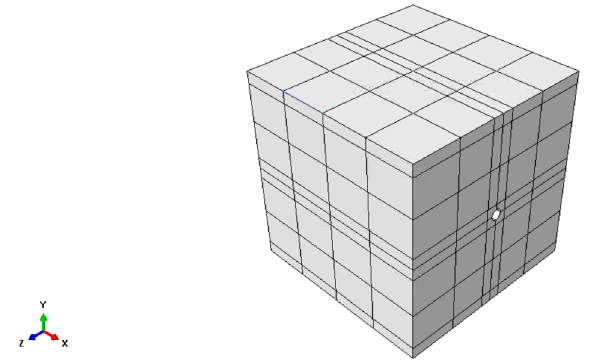
Figure 2. A 500 mm × 500 mm × 500 mm concrete box.